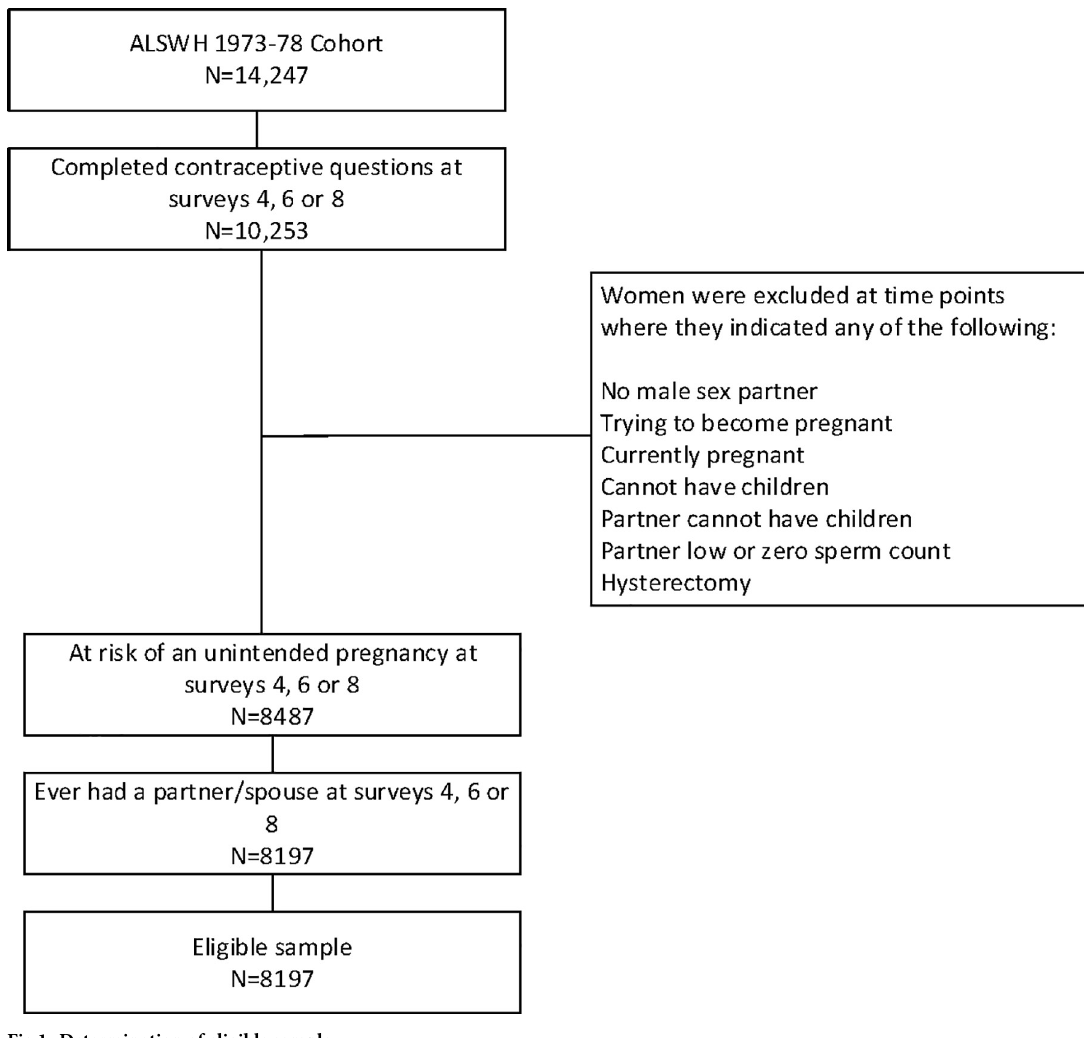
Fig 1. Determination of eligible